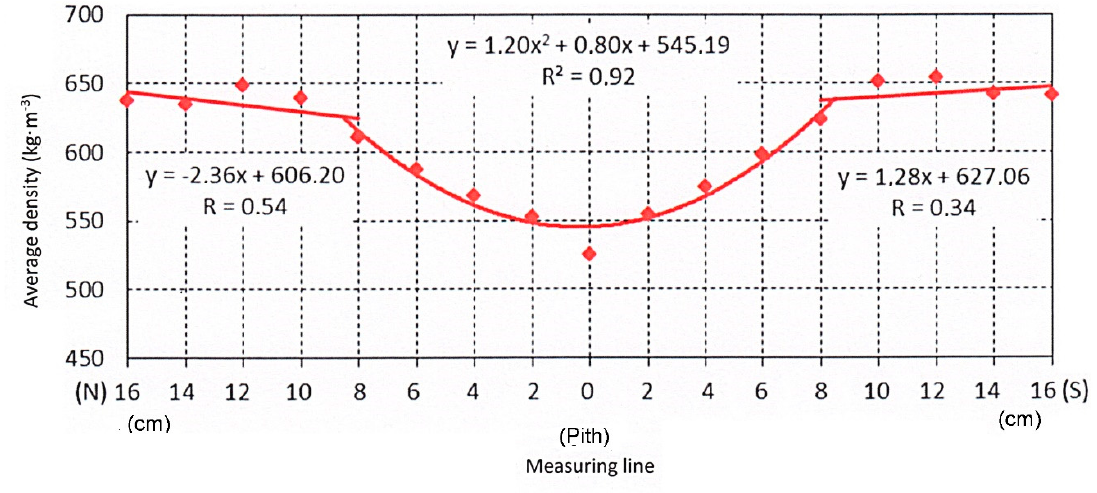
Figure 4. Distribution of average densities on the cross-section of birch log at breast height. Two-sided tests of significance of correlation coe ffi cients showed that, in both cases, the correlation